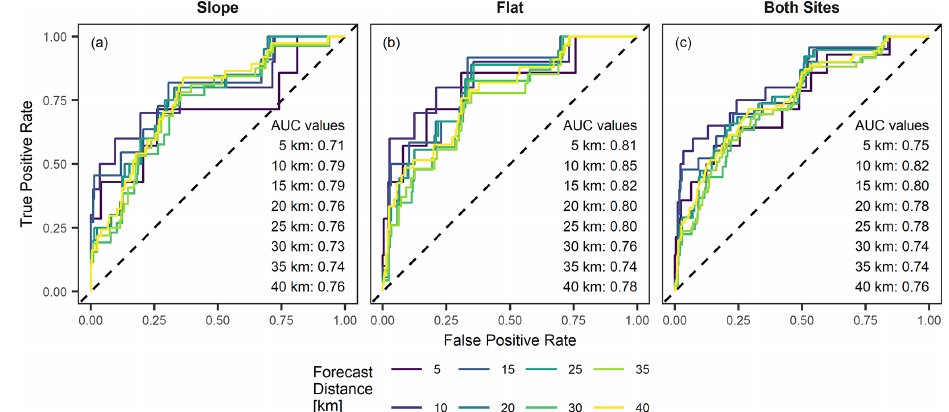
Figure 10. ROC curves and AUC values at the sloped (a) and flat site (b) , as well as at both sites combined (c) . Landslide predictions are based on a logistic regression model that predicts landslide probability based on antecedent saturation and saturation change and which was fitted to 35 sites in Switzerland over the time period 2008–2018. The colours correspond to different forecast distances.